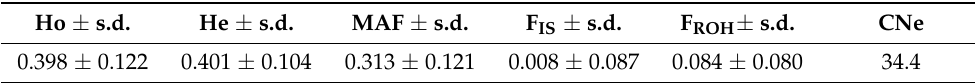
Table 2. Estimates of genetic diversity indices in Mascaruna goat.